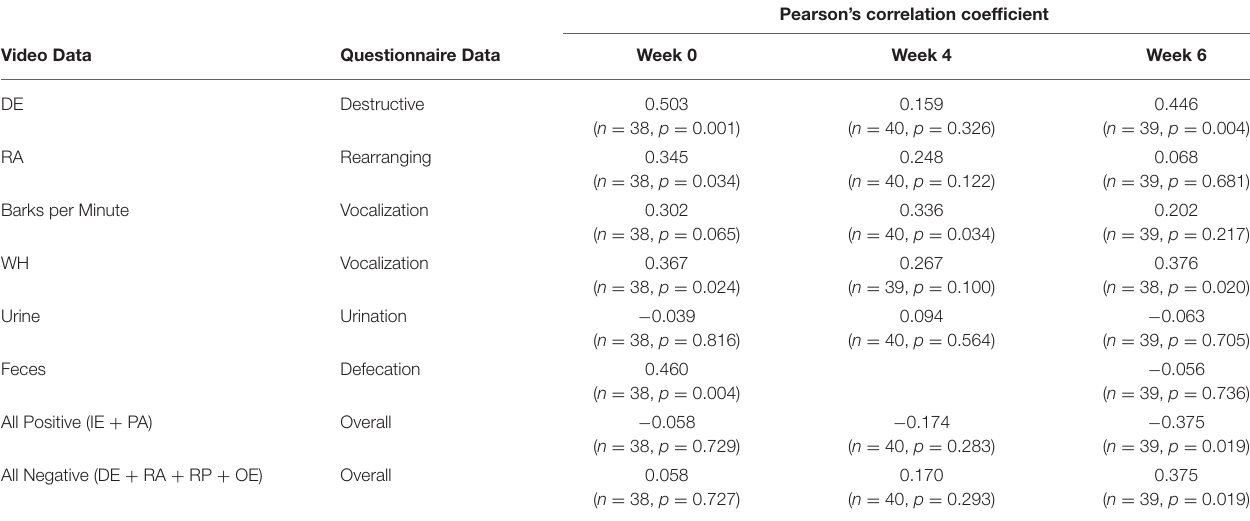
TABLE 7 | Correlations between the video data and questionnaire data, separated by time (Baseline, week 4, and week